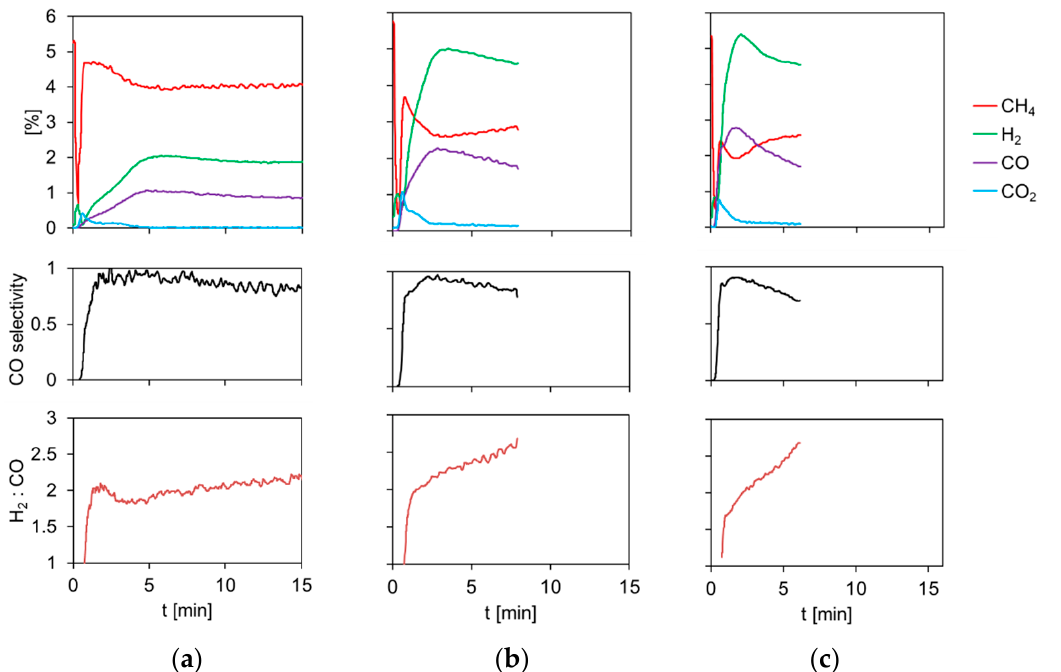
Figure 5. Reduction steps under fixed-bed conditions at 860 °C ( a ), 920 °C ( b ), 1000 °C, ( c ) with 5%.